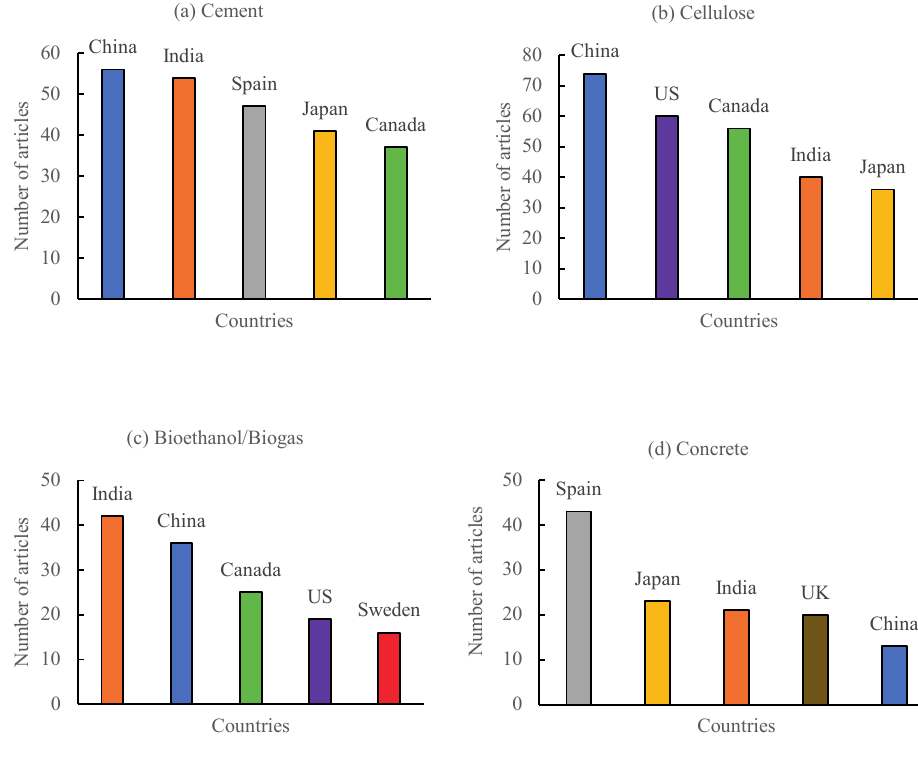
Fig. 7. Five countries with the most publications on the selected paper sludge major